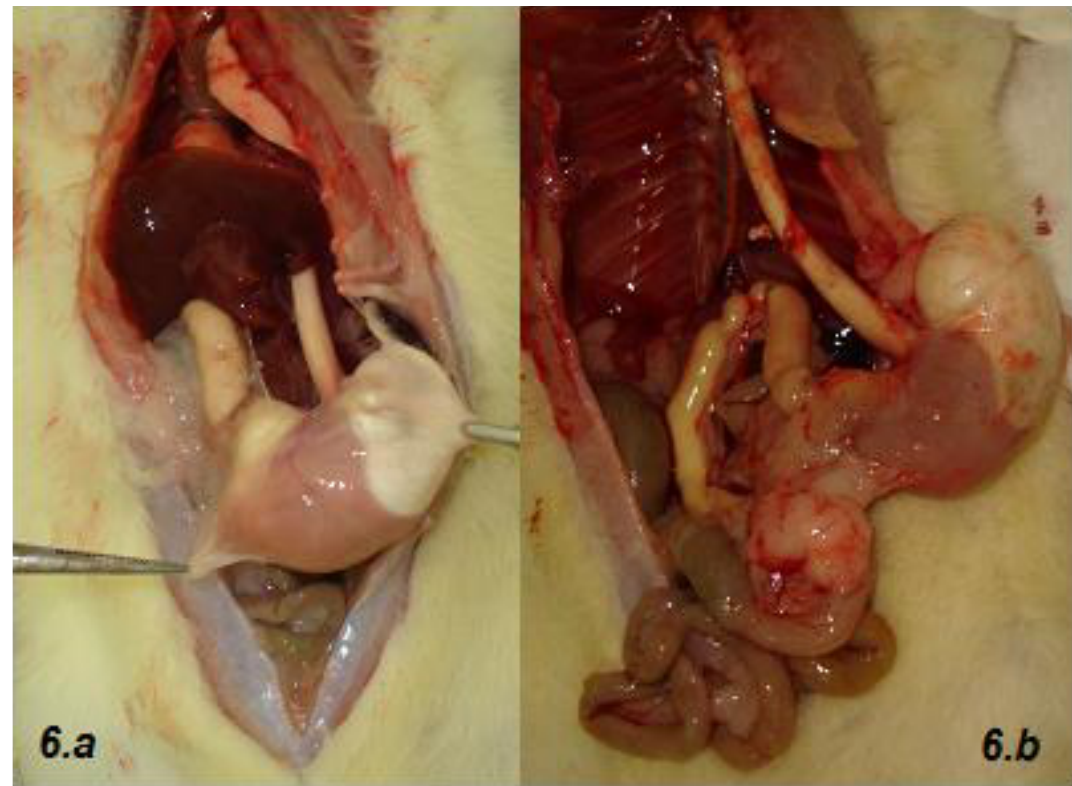
FIGURE 6 – a. Necropsy showing the median incision and the location of the organs in the abdominal cavity. b. Necropsy showing the thoracic and abdominal locations of the esophagus, as well as the stomach and the